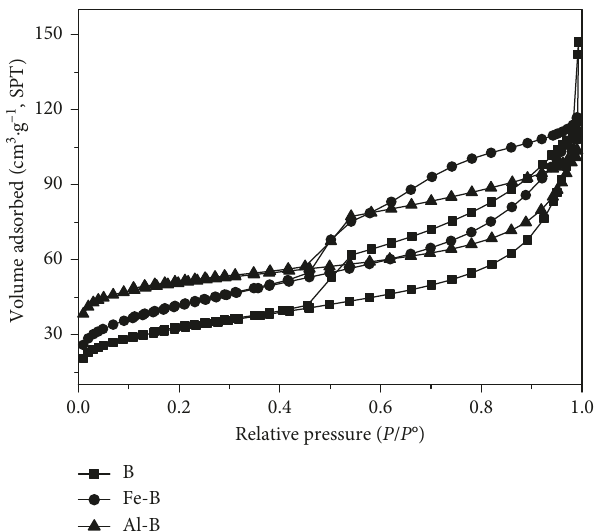
Figure 4: N 2 adsorption/desorption isotherms of B, Fe-B, and Al-B.